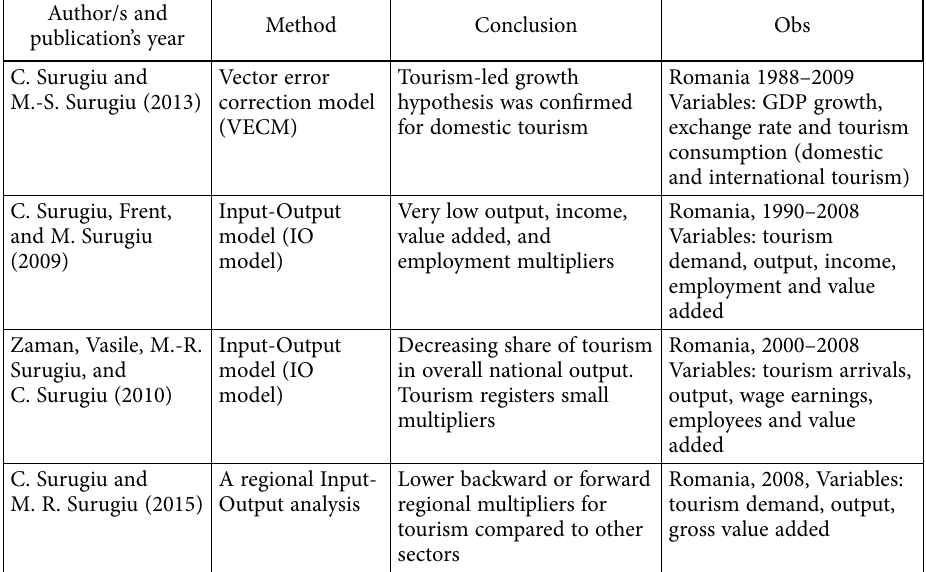
Table 1. Empirical studies on the tourism-growth causal relationship in Romania (source: own